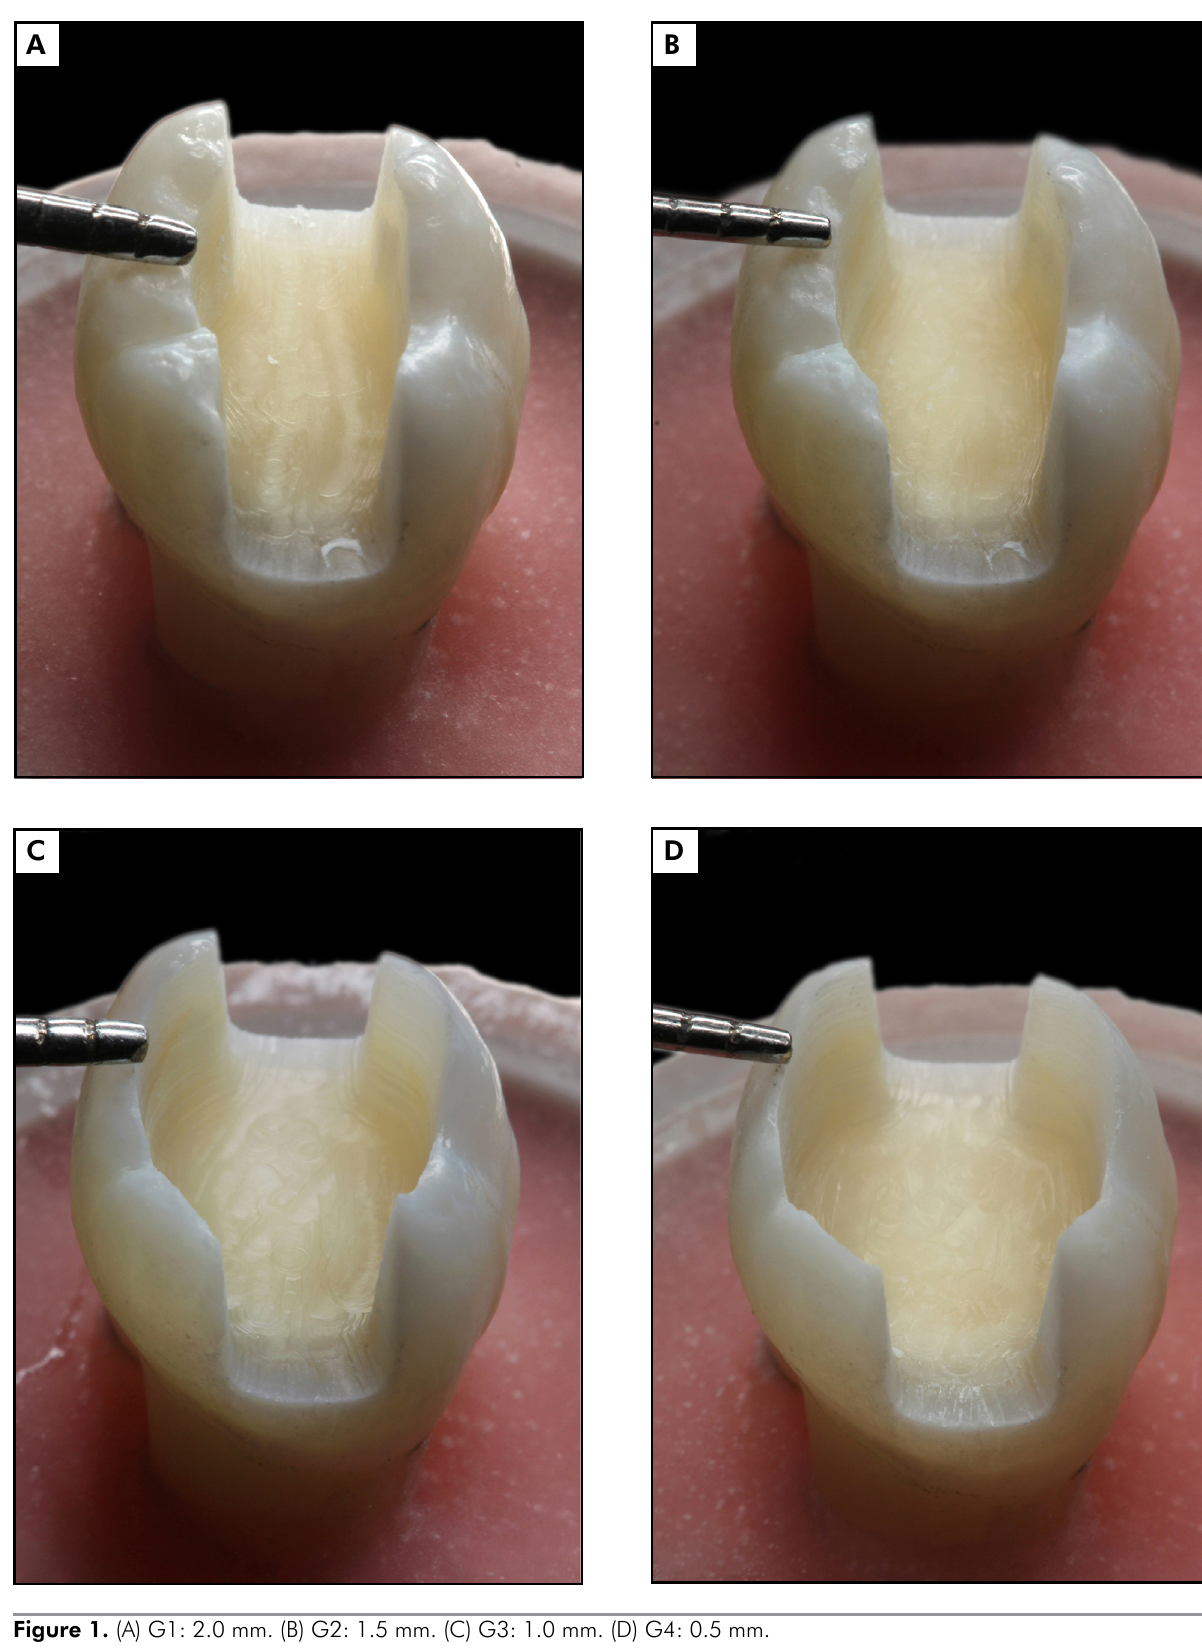
Figure 1. (A) G1: 2.0 mm. (B) G2: 1.5 mm. (C) G3: 1.0 mm. (D) G4: 0.5